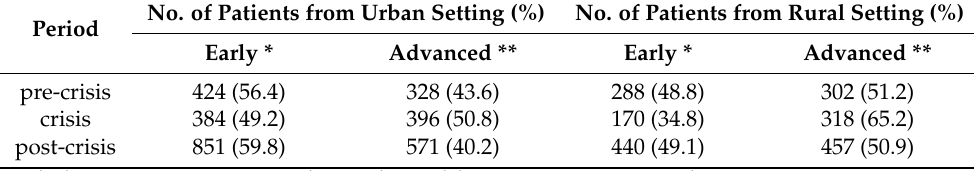
Table 3. Distribution of study group by setting and moment of